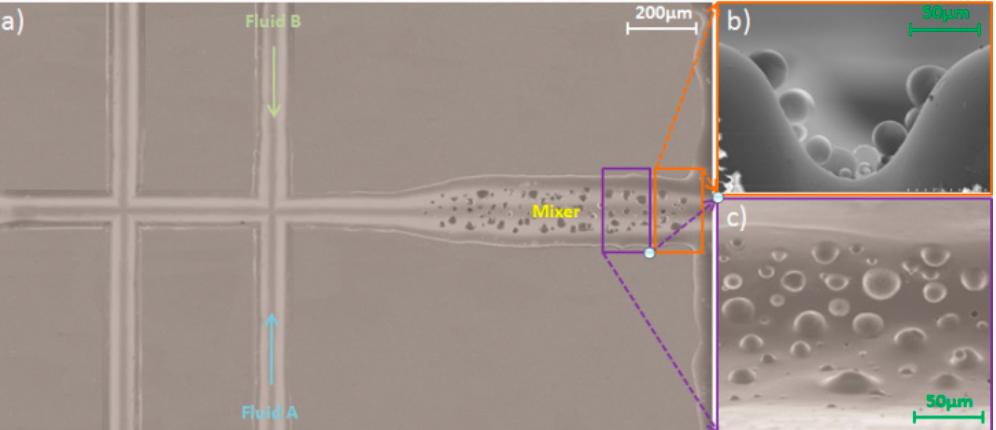
Figure 10. SEM images of the fabricated device showing ( a ) an overall view of the device and ( b ) showing the cross section of the ablated mixing channel; ( c ) showing the inner surface of the mixing channel. (length of mixing channel = 500 µm, applied potential = 300 V/cm).